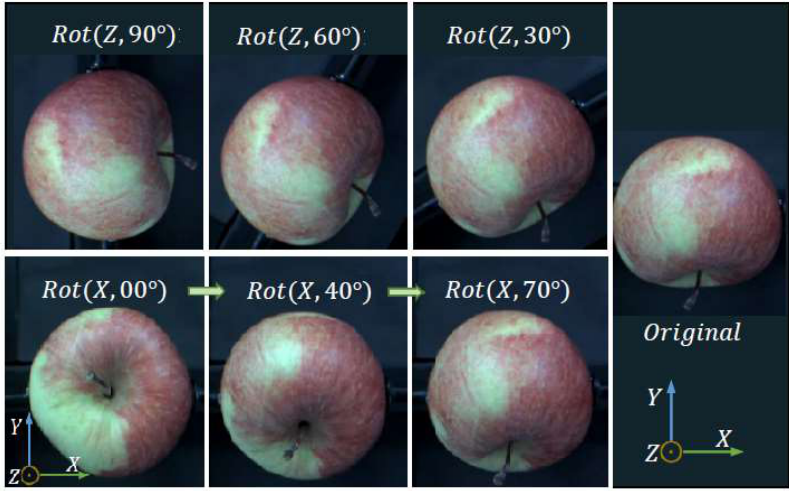
Figure 2. Rotation axes of apples used.